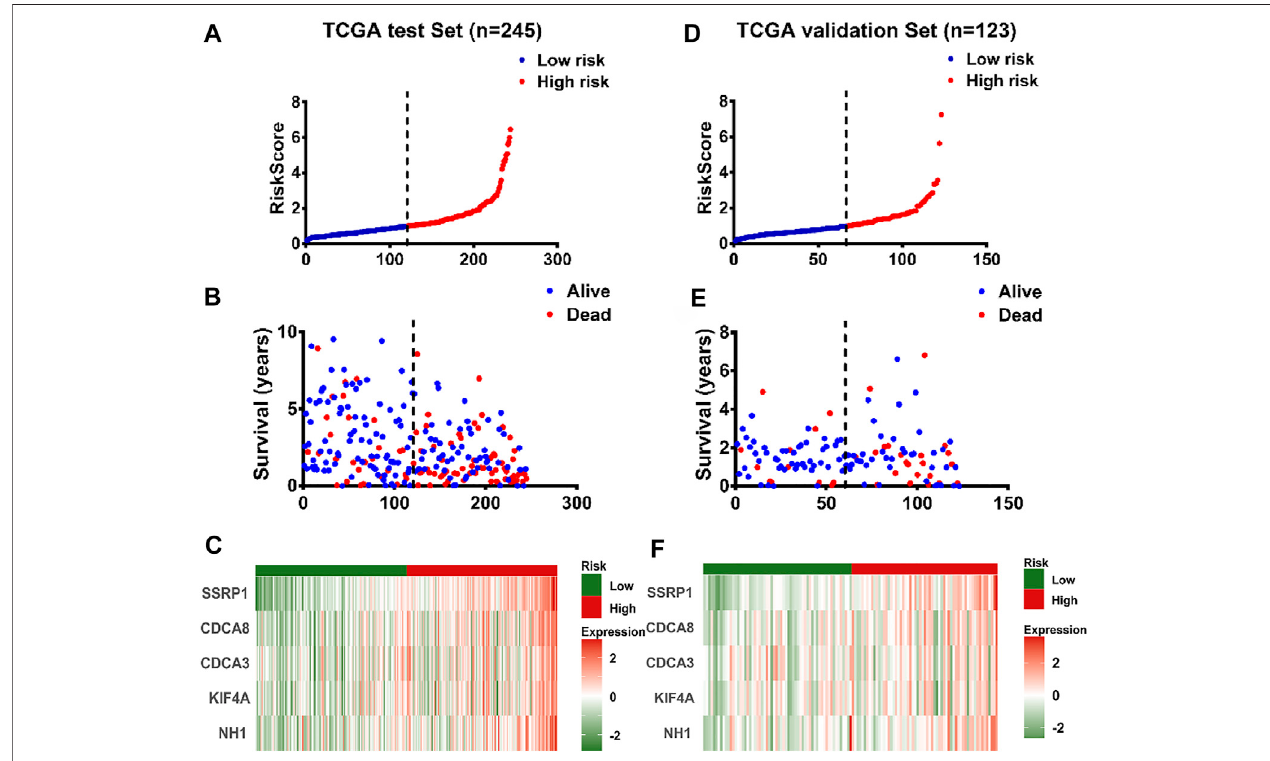
FIGURE7| ValidationofthepanelofE2Ftargetgenessignaturebytestsetandvalidationset (A) ThedistributionofriskscoresinpatientswithlivercancerbyTCGA testset(n=245) (B) ThesurvivaltimeandsurvivalstatusofpatientswithlivercancerrankedbyriskscoresbyTCGAtestset(n=245) (C) Thedistributionofexpressionof the fi ve genes in heatmap in patients with liver cancer ranked by risk scores by TCGA test set (n = 245) (D) The distribution of risk scores in patients with liver cancer by TCGA validation set (n = 123) (E) The survival time and survival status of patients with liver cancer ranked by risk scores by TCGA validation set (n = 123) (F) The distribution of expression of the fi ve genes in heatmap ranked by risk score in patients with liver cancer by TCGA validation set (n = 123).